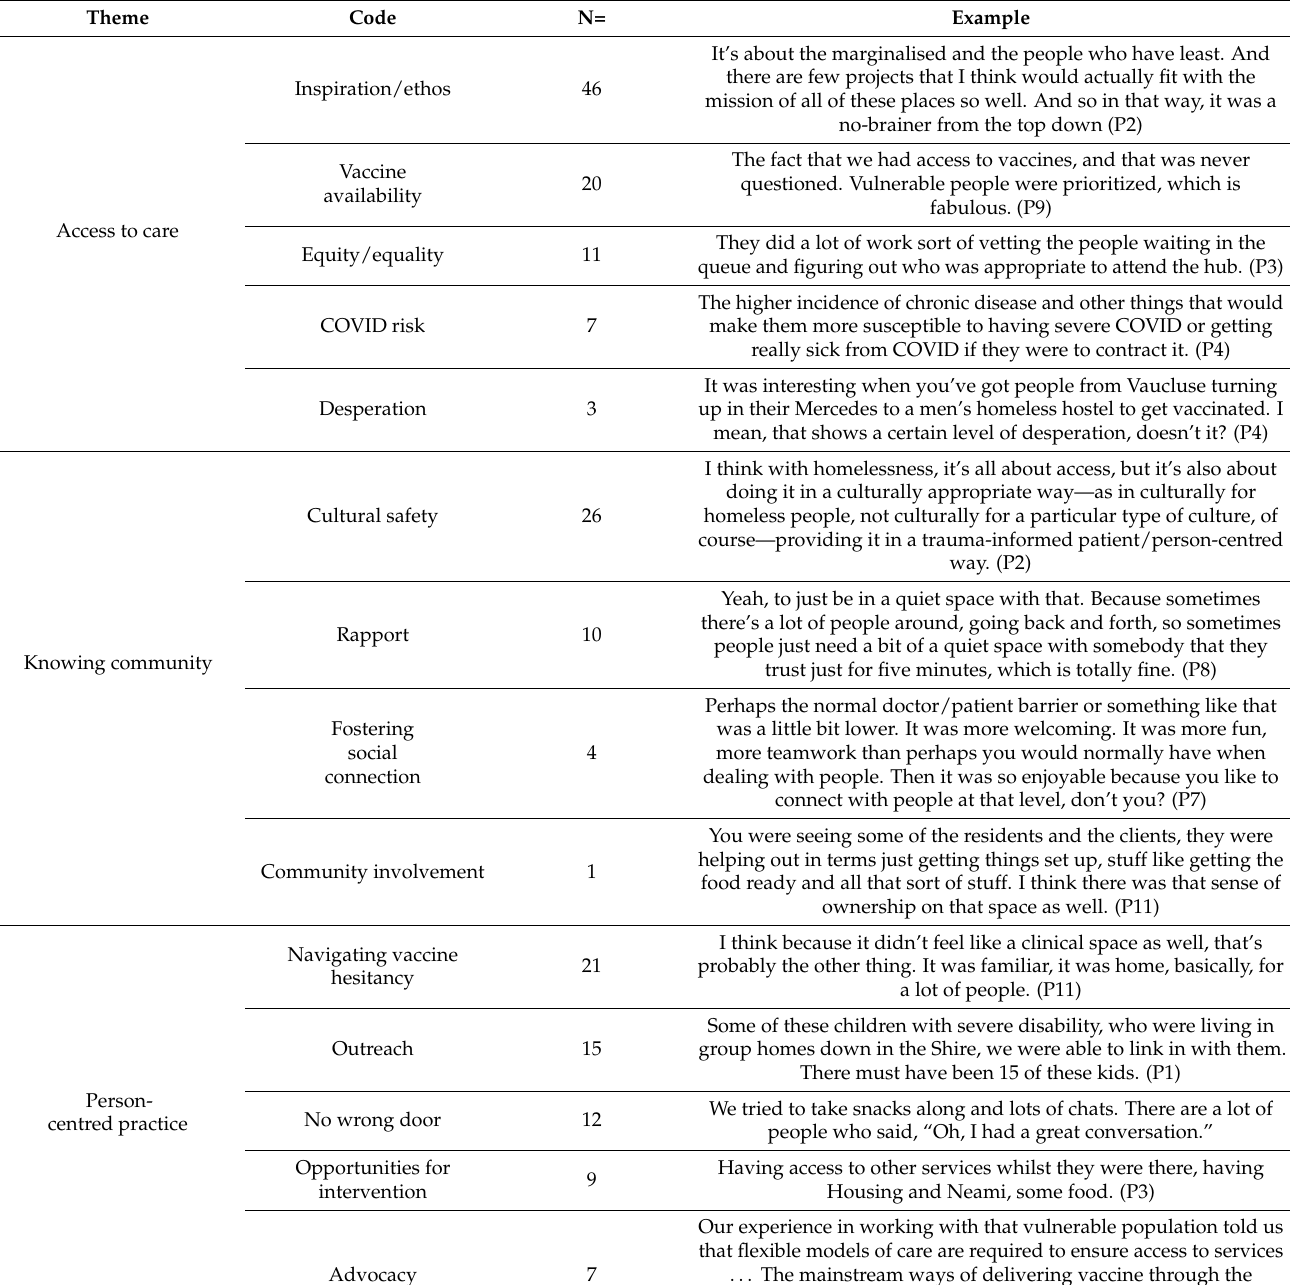
Table 4. Qualitative interview